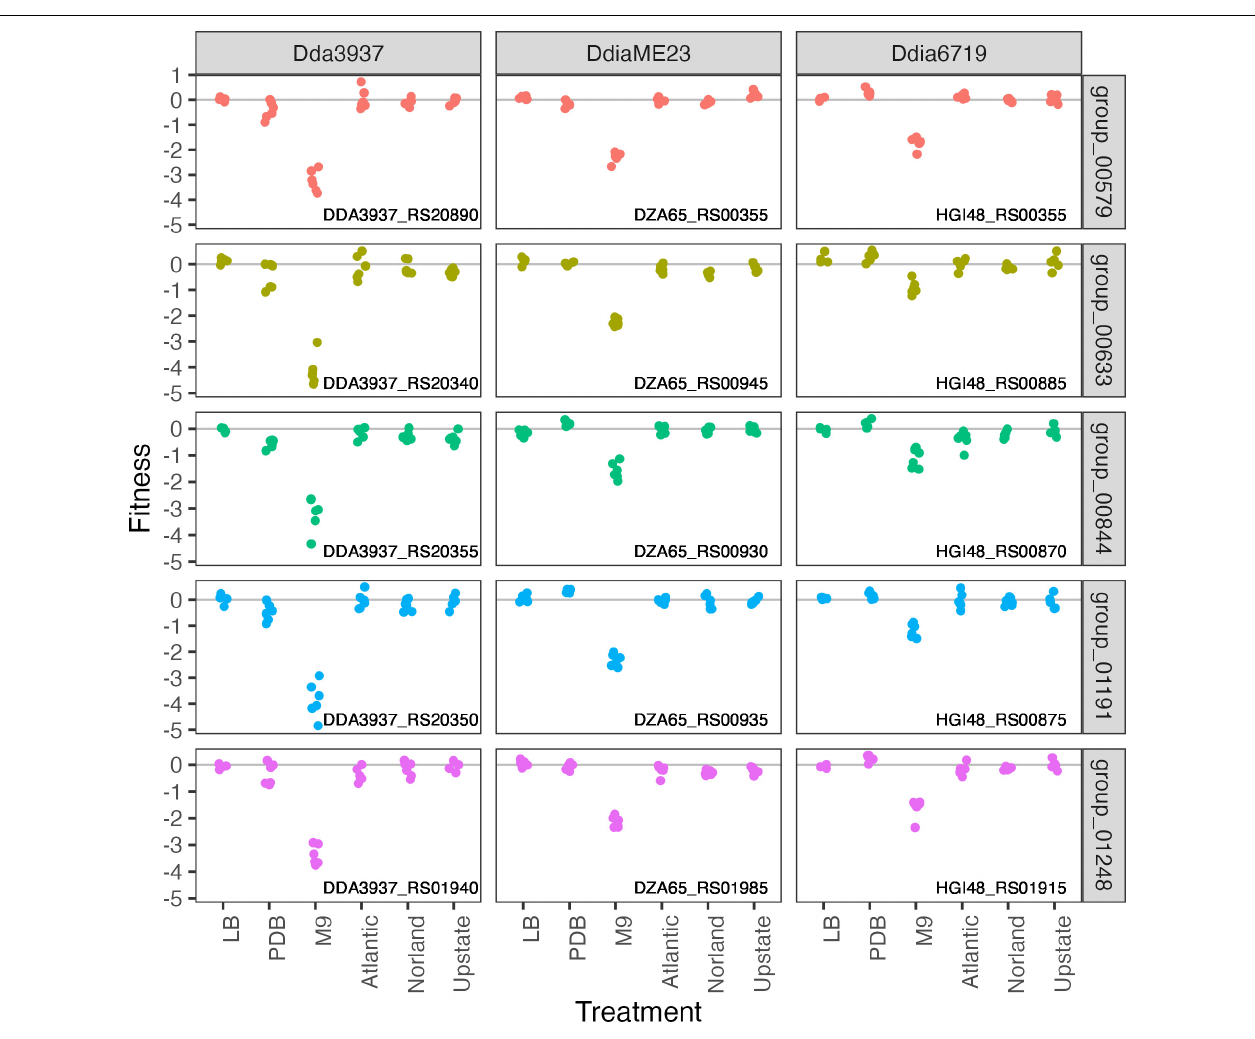
FIGURE 4 | Mutations in arginine biosynthetic genes are detrimental only in M9 minimal medium. Gene fitness values for argininosuccinate synthase ArgG (group 00579), argininosuccinate lyase ArgH (group 00633), acetylornithine deacetylase ArgE (group 00844), N-acetyl-gamma-glutamyl-phosphate reductase ArgC (group 01191), and ornithine carbamoyltransferase ArgF (group